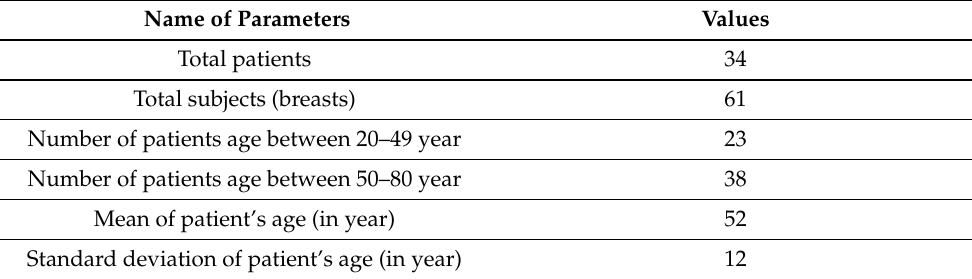
Table 1. Summary of the patient population used in this study.